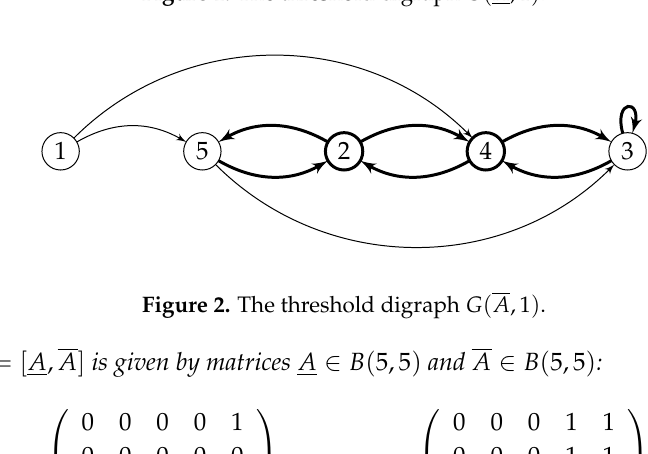
Figure 1. The threshold digraph G ( A ,1 ) .